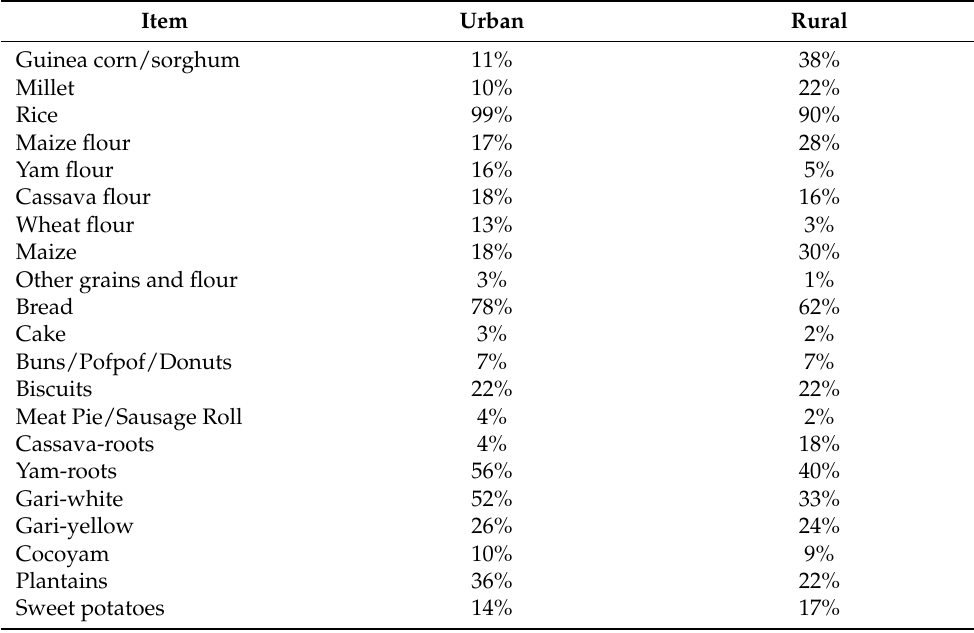
Table A5. Foods consumed in the 7 days prior to the survey by urban and rural Nigerian house- holds